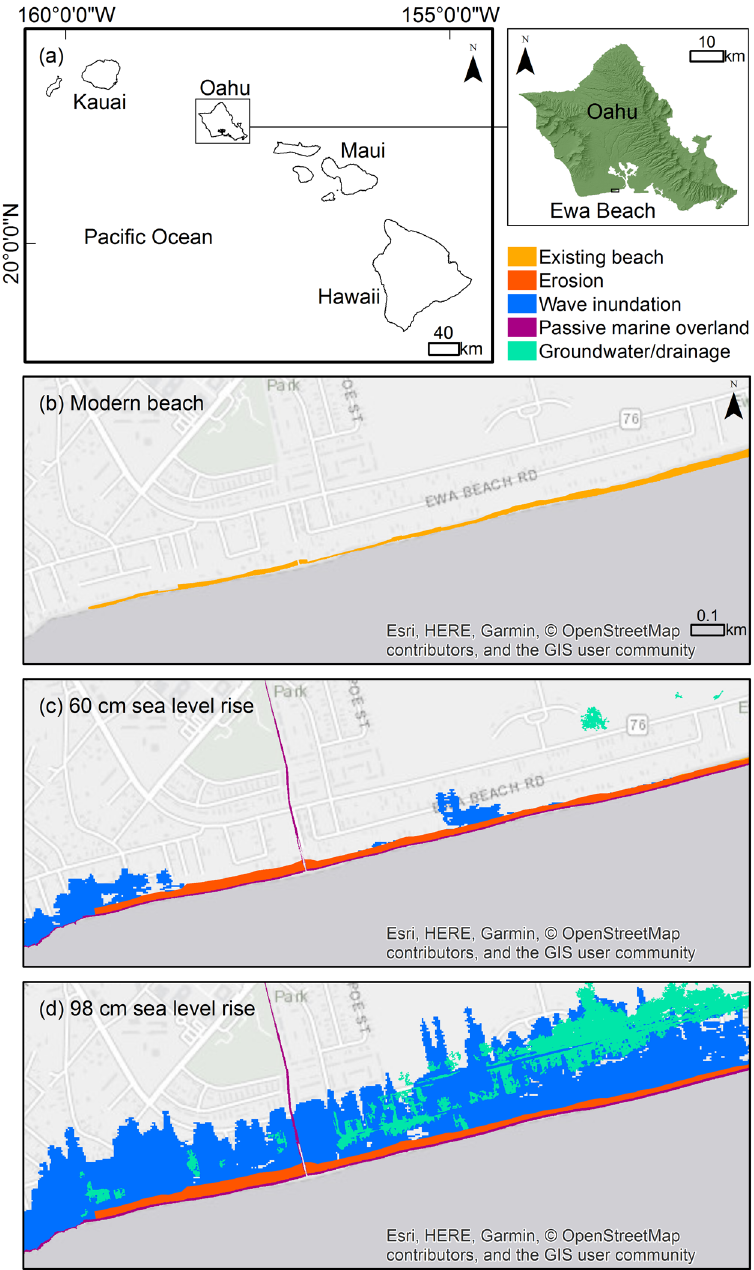
Figure 2. Modeled exposure to sea level-related hazards at ‘Ewa Beach, O‘ahu, show the localized spatial distribution of lands exposed to passive marine overland flooding at high tide (maroon), passive groundwater flooding/drainage backflow from the ocean at high tide (green), seasonal wave inundation (dark blue), and chronic erosion (red). The existing beach area is shown in orange; ( a ) location map; ( b ) present-day beach; ( c ) 0.60 m SLR scenario; ( d ) 0.98 m SLR scenario. (The cartography in the OpenStreetMap map tiles is licensed under CC BY-SA. The license terms can be found at: